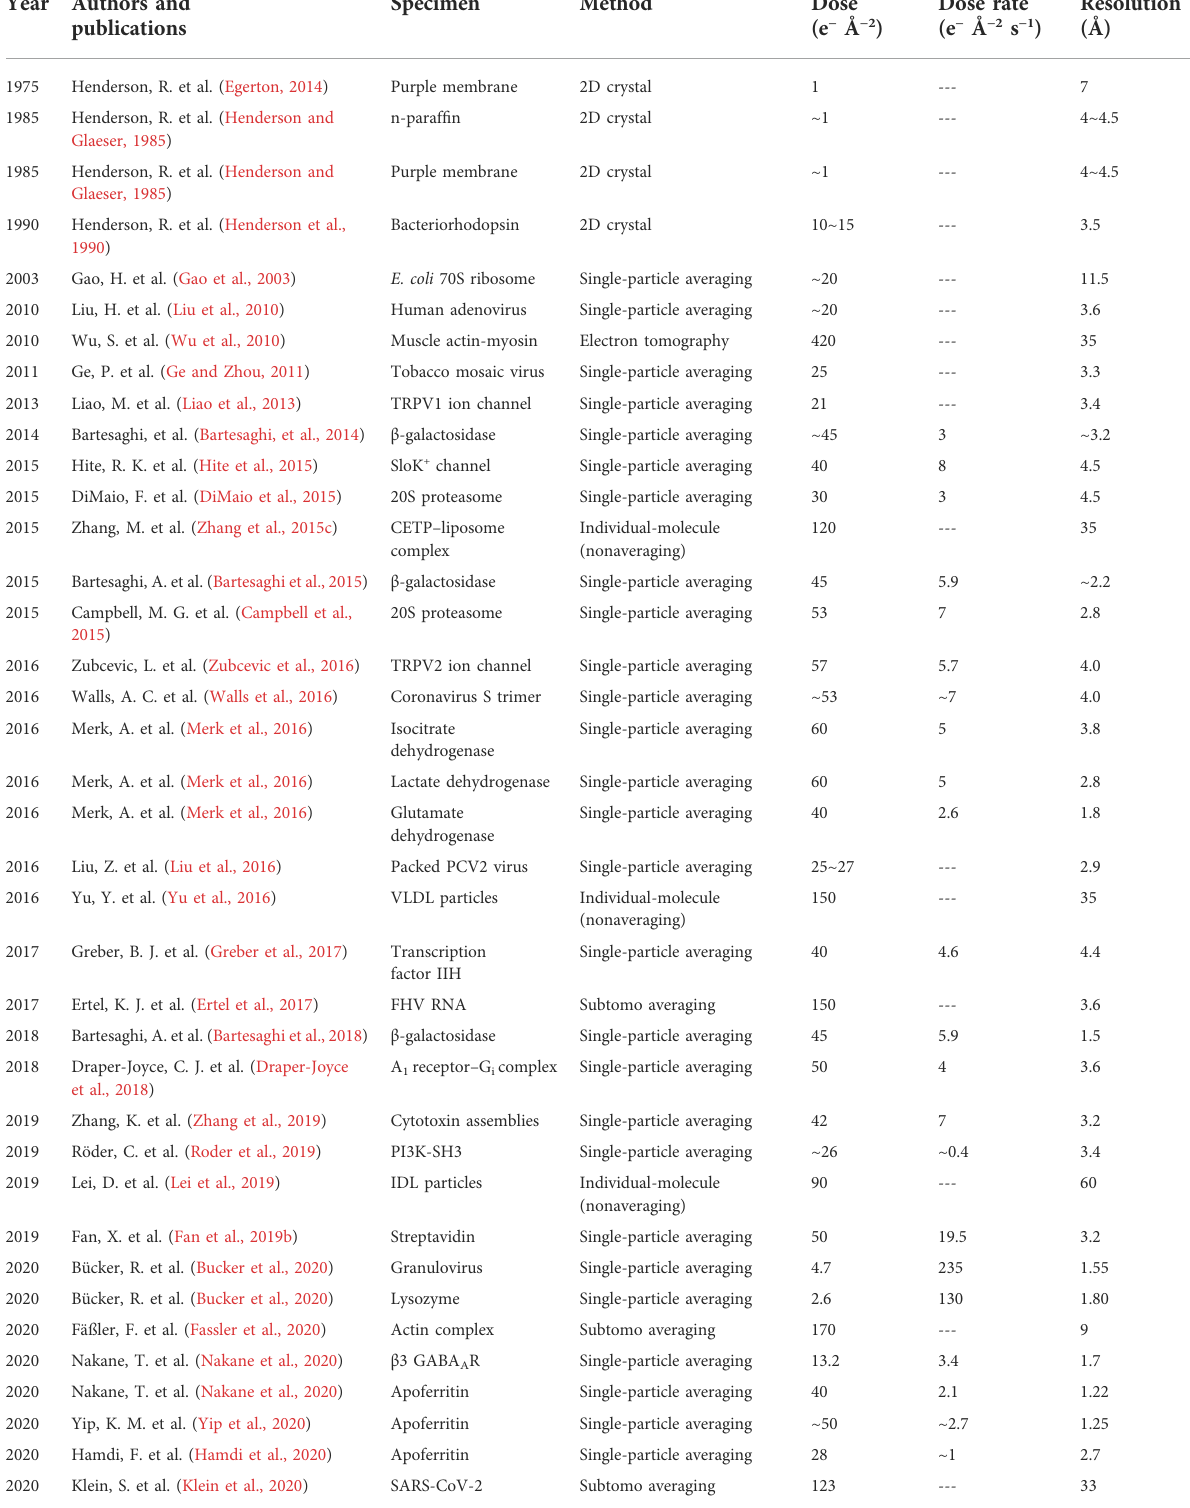
TABLE 1 Selected cryo-EM/cryo-ET 3D reconstructions with corresponding experimental